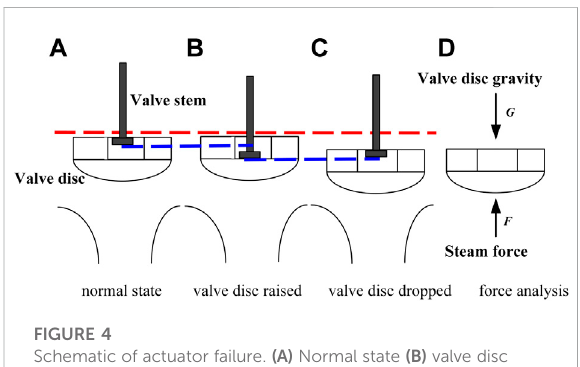
FIGURE 3 Flow characteristic curve.